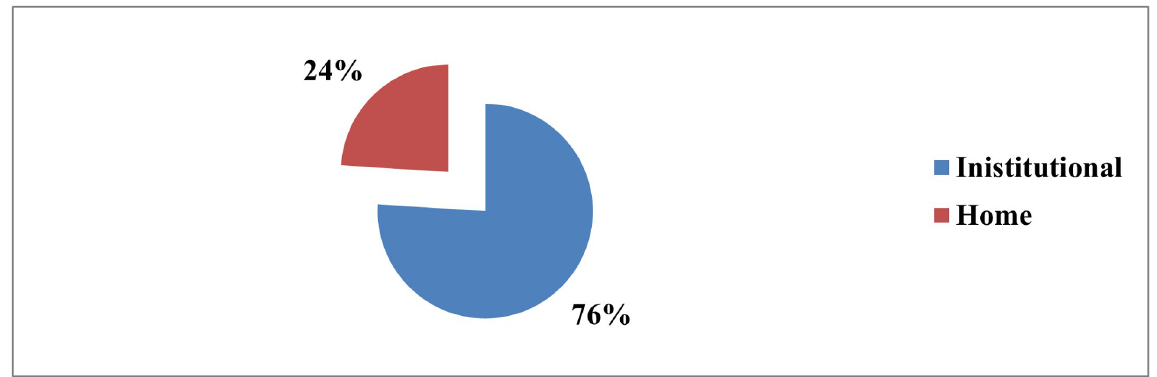
Fig 2. Distribution of pregnant women place birth preference in Arba Minch health demographic surveillance site May 2021.